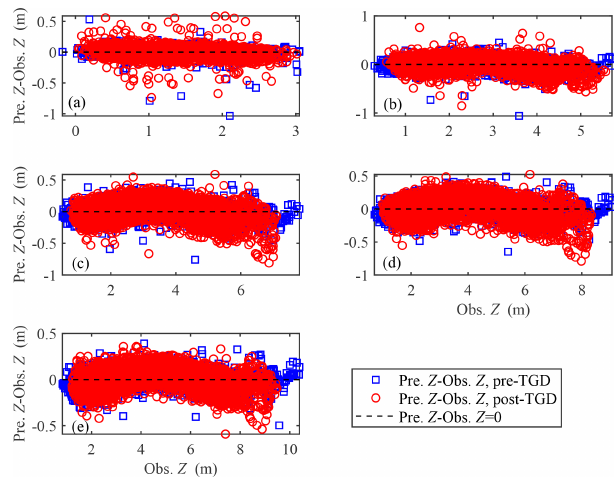
Figure 2. Alterations in difference between predicted and observed daily averaged water levels as a function of observed daily averaged water levels for both the pre-TGD and post-TGD periods at different gauging stations along the upper YRE: (a) Jiangyin (JY), (b) Zhen- jiang (ZJ), (c) Nanjing (NJ), (d) Maanshan (MAS), (e) Wuhu